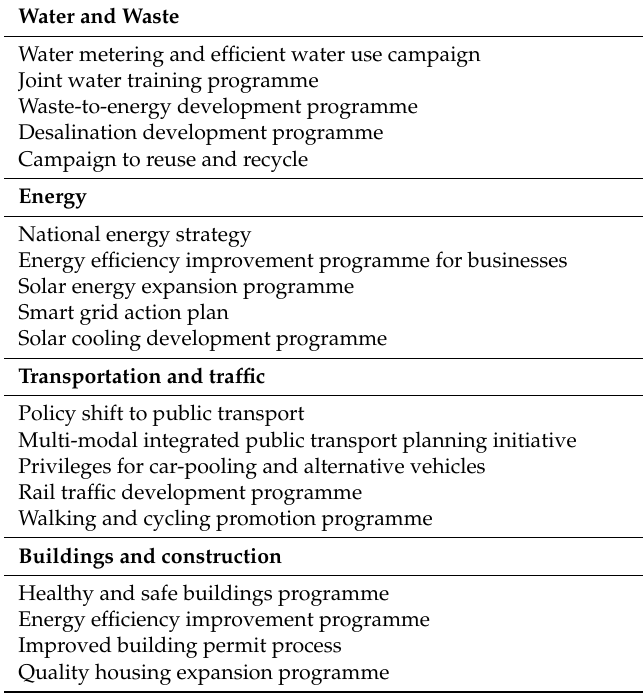
Table 2. List of proposed implementation actions for realizing the roadmap